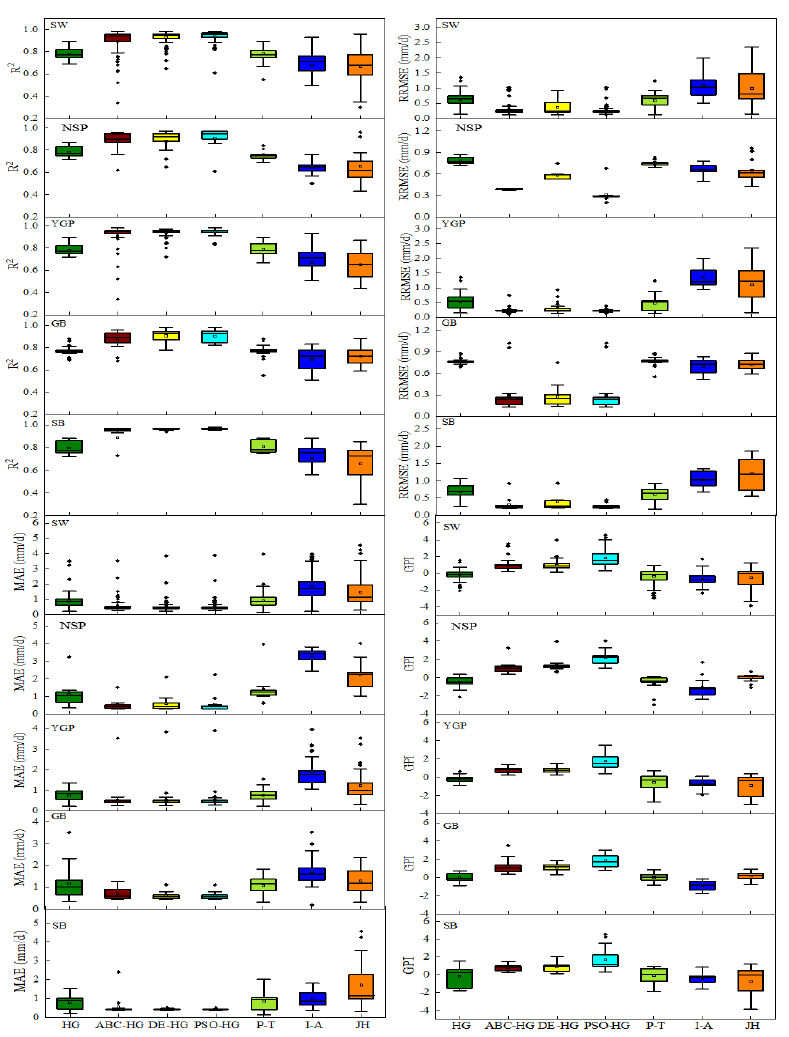
Figure 4. Based on ABC, DE and PSO algorithms, HG model and four empirical models are calibrated to estimate daily ET 0 accuracy of stations in Southwest China and four regions. Note: HG, PT, IA and JH represent Hargreaves, Priestley– Taylor, Imark–Allen and Jensen–Hais, respectively. NSP: Northwest Sichuan Plateau; GB: Guangxi Basin; SB: Sichuan Basin; YGP: Yunnan–Guizhou Plateau.